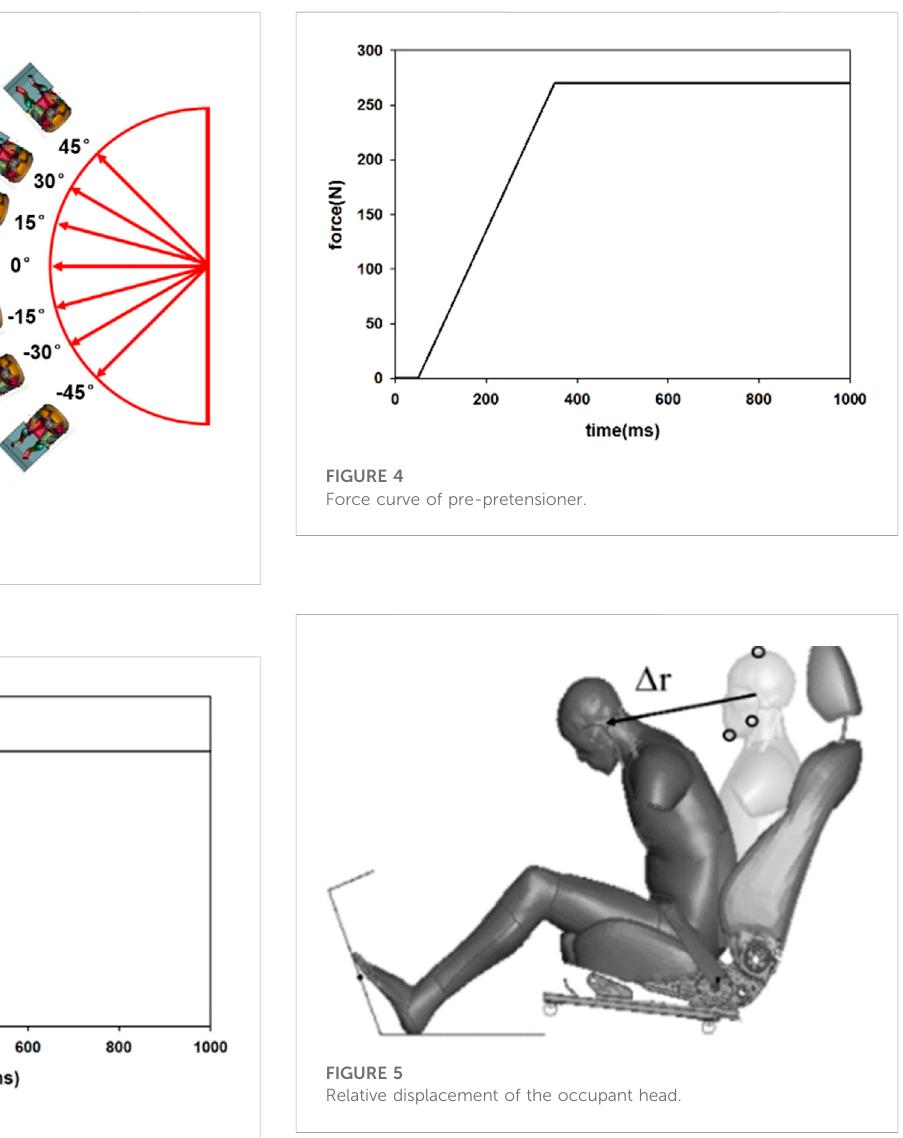
FIGURE 3 Pulse of AEB.